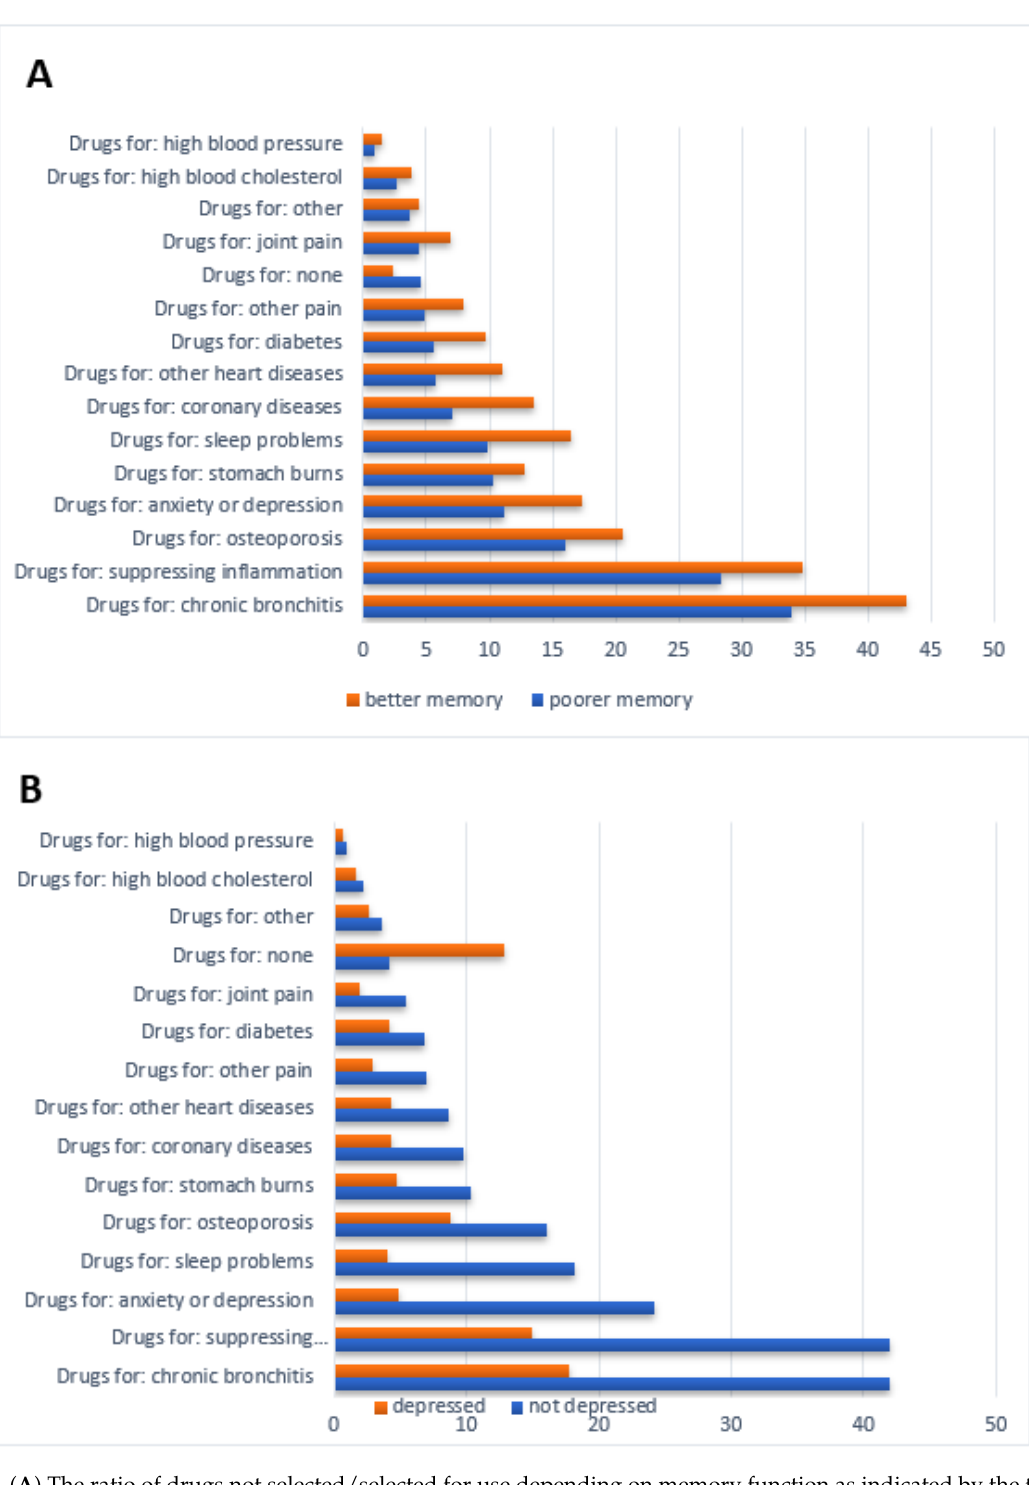
Figure 2. ( A ) The ratio of drugs not selected/selected for use depending on memory function as indicated by the ten-word list learning delayed recall (poorer memory <5 words correct, better memory ≥ 5 words correct). ( B ) The ratio of drugs not selected/selected for use depending on their depression status (EURO-D <3 or ≥ 4).